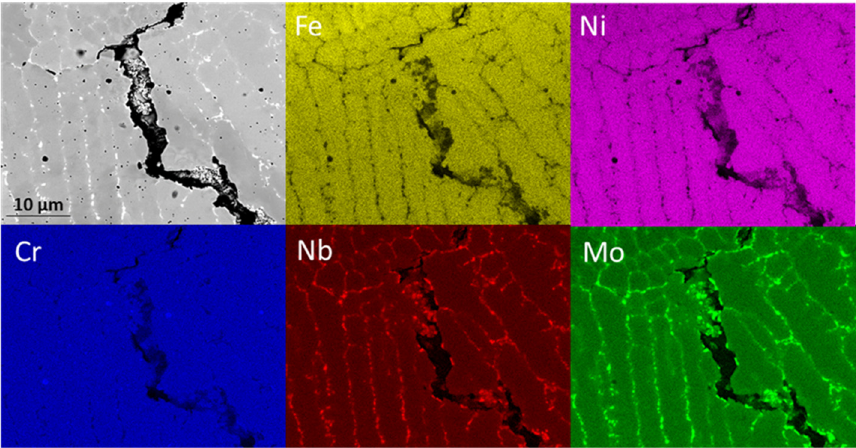
Figure 3. SEM image and EDS elemental maps of a discontinuity observed in 75% M625 + 50% M42C layer, illustrated as black square inset in Figure 2.